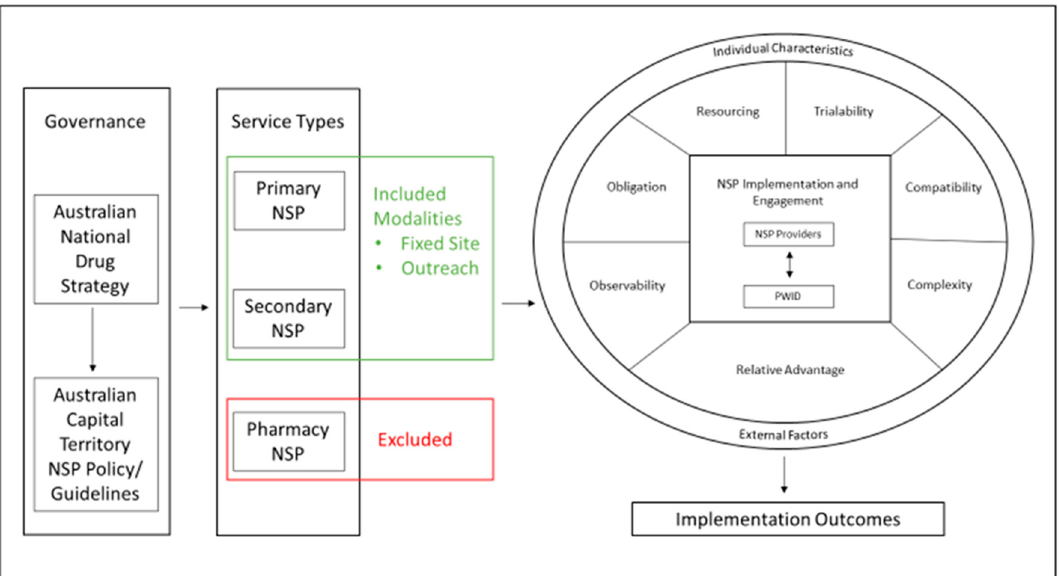
Figure 1. Conceptual